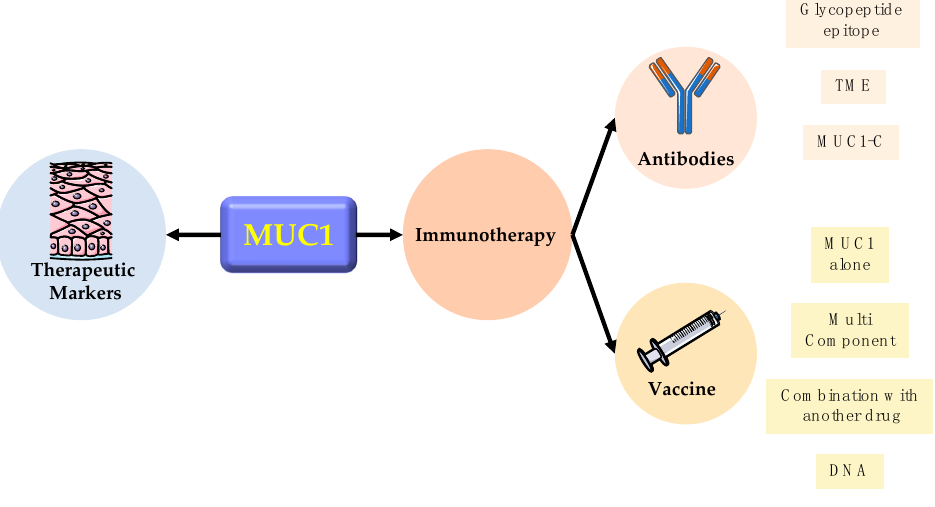
Figure 3. Clinical applications of MUC1.